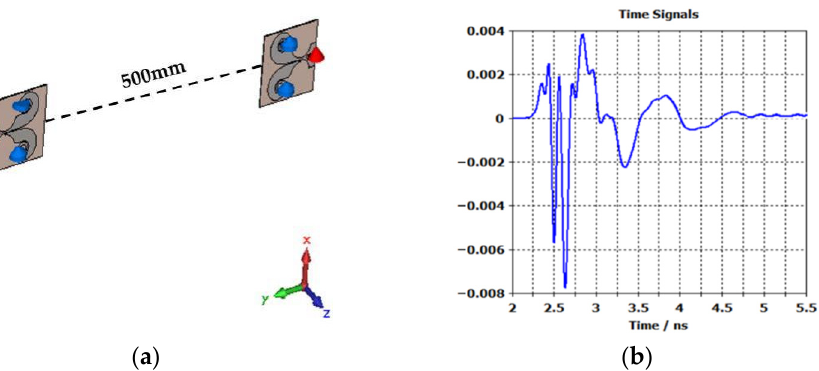
Figure 11. Conformal antenna and its performance in time domain: ( a ) conformal antenna and ( b ) received signal.